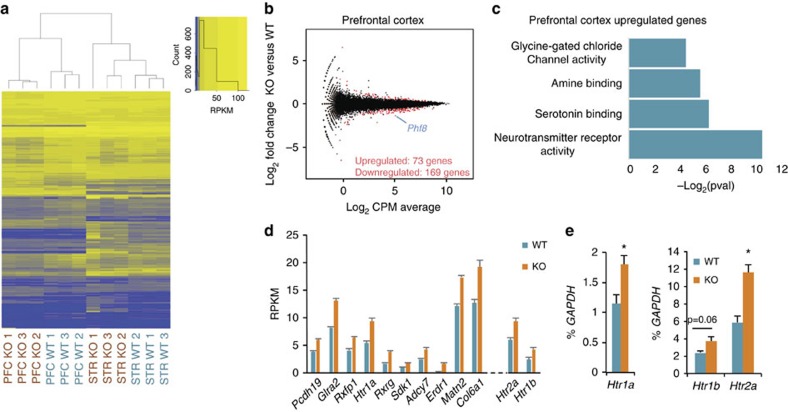
Loss of Phf8 in the prefrontal cortex causes misregulation of serotonin receptors.(a) Unbiased hierarchical clustering and heatmap for differentially expressed genes between Phf8 WT and KO prefrontal cortex and ventral striatum. (b) Mean Average plots comparing Phf8 WT and KO RNA-seq data from prefrontal cortex. Differentially expressed genes (p<0.05, FDR<0.05) between WT and KO for each sample set are shown in red. (c) Gene ontology (GO) molecular function analysis (GO database released 2016-09-24) of the differentially expressed (upregulated and downregulated) gene sets from the prefrontal cortex (1.4 fold cutoff, FDR<0.05). The negative log2 of the Bonferroni corrected p value is displayed along the x-axis for all categories for which p<0.05. Enrichments for each category: Neurotransmitter Receptor Activity 6/93, Serotonin Binding 3/11, Amine Binding 3/13, Glycine Gated Channel Activity 2/2. (d) RNA-seq expression data of the top 10 most significantly differentially expressed genes in the prefrontal cortex ranked in order of descending p value, note the presence of the Htr1a serotonin receptor. Also shown (out of rank order) are the serotonin receptors Htr2a and Htr1b. (e) RT-qPCR analysis confirms upregulation of Htr1a, Htr1b and Htr2a expression in the prefrontal cortices of an independent set of mice (WT: n=3, KO: n=4). Error bars=s.e.m. *=p<0.05 (Student's t-test, two-tailed).